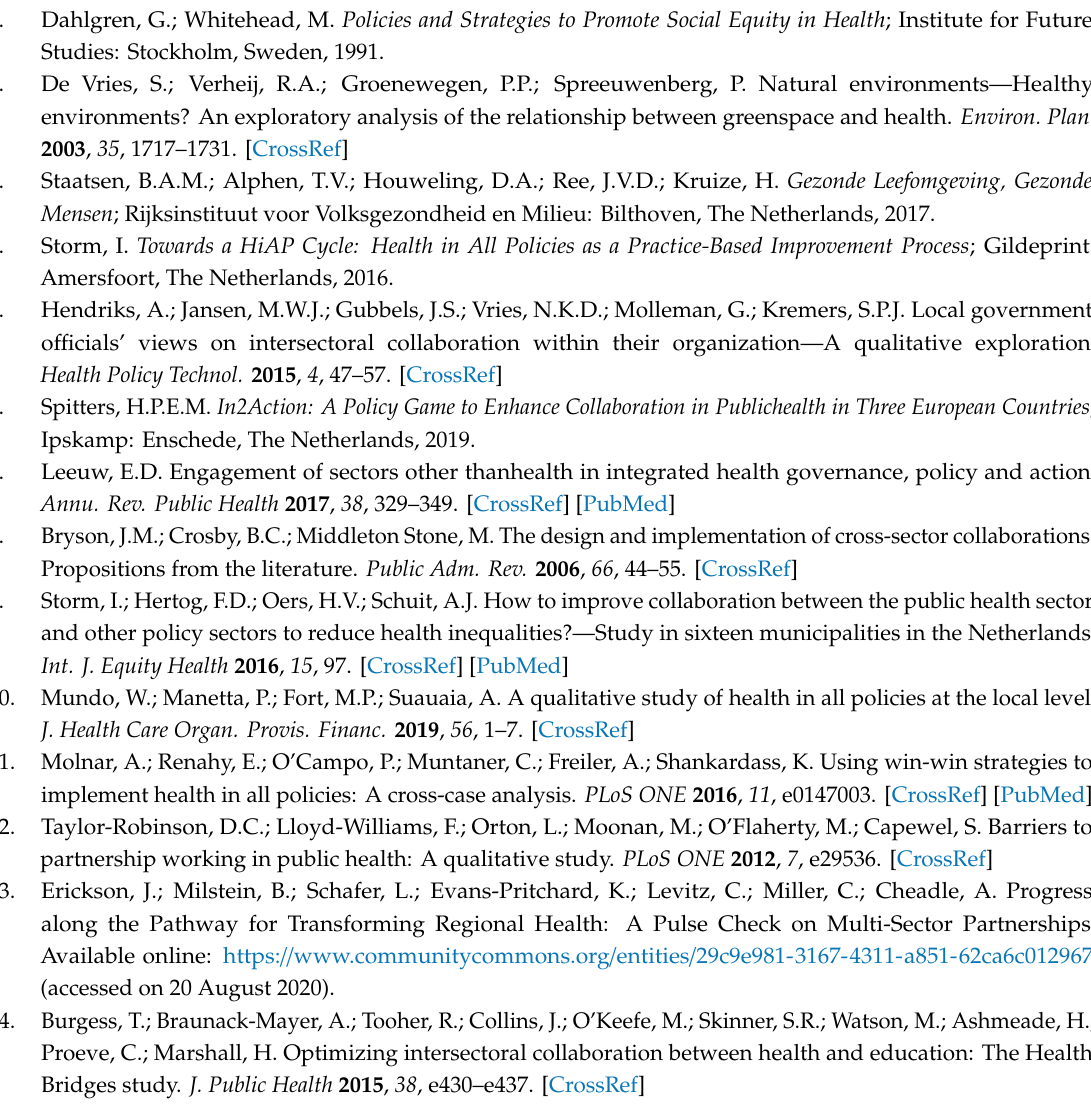
Supplementary Table S1: Interviewed regional partners. Supplementary S2: Interview guide. Supplementary Table S3: Strategy-Context-Mechanism-Outcome configurations per theme for cross-sector